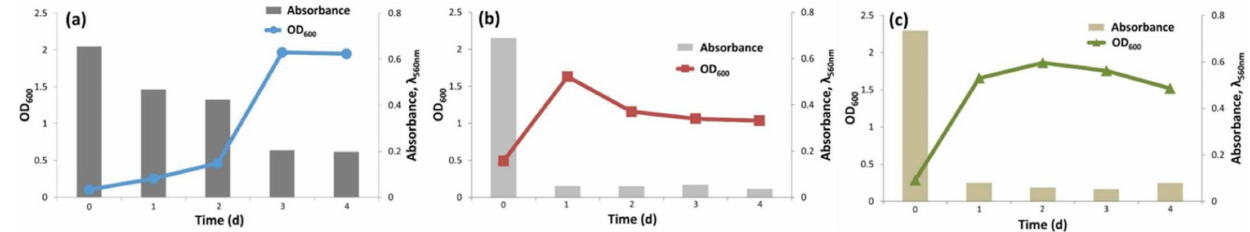
Figure 2. Comparative analysis of consortium cultural growth and concomitant decolorization of the azo dye Acid Blue 113 (50 mg/L) over time. ( a ) B-C, ( b ) Y-C, and ( c )